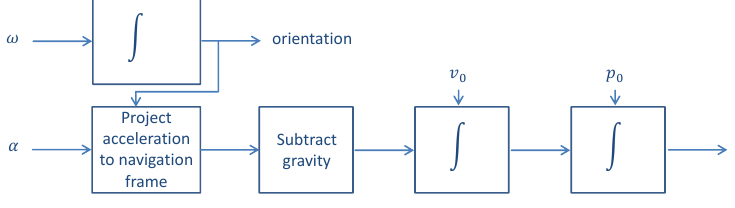
Figure 1. Block diagram of the strapdown inertial positioning